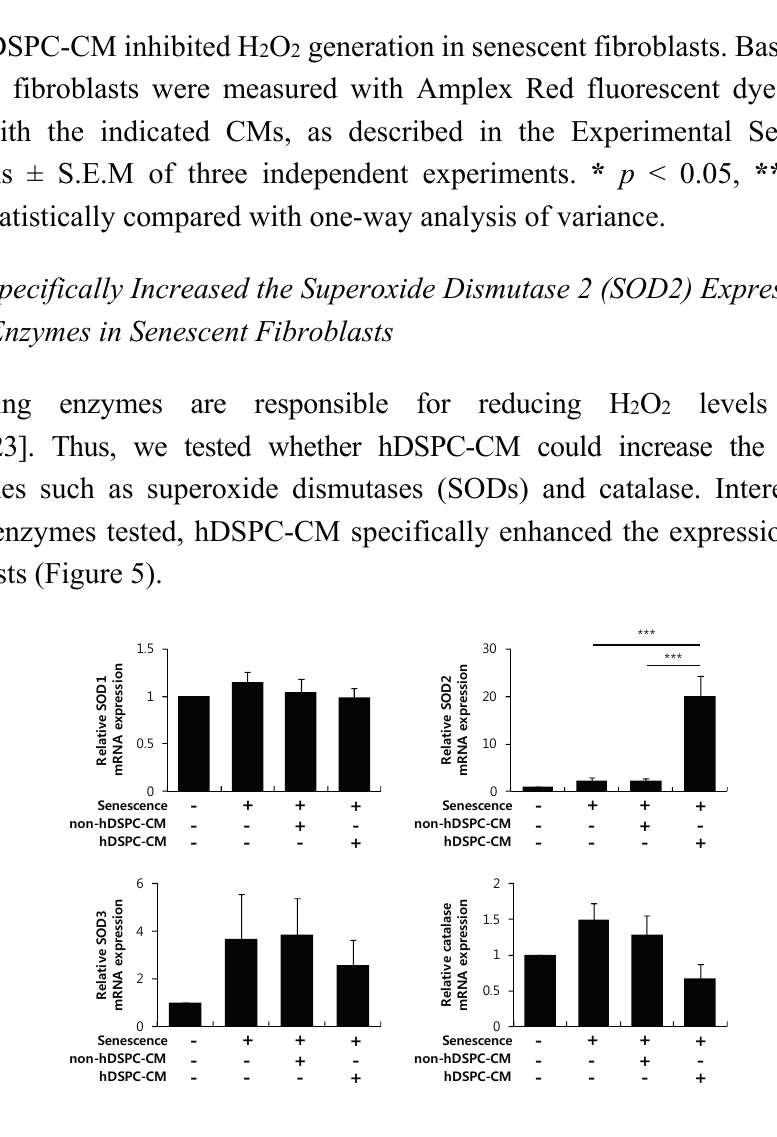
Figure 5. hDSPC-CM specifically up-regulated the expression level of the ROS scavenging enzyme SOD2 in senescent fibroblasts. Senescent fibroblasts were treated with either hDSPC-CM or non-hDSPC-CM for 24 h. Real-time RT-PCR was performed for SOD1 , SOD2 , SOD3 , and catalase. Graphs depict means ± S.E.M of four independent experiments. *** p < 0.001. Data were compared with one-way analysis of